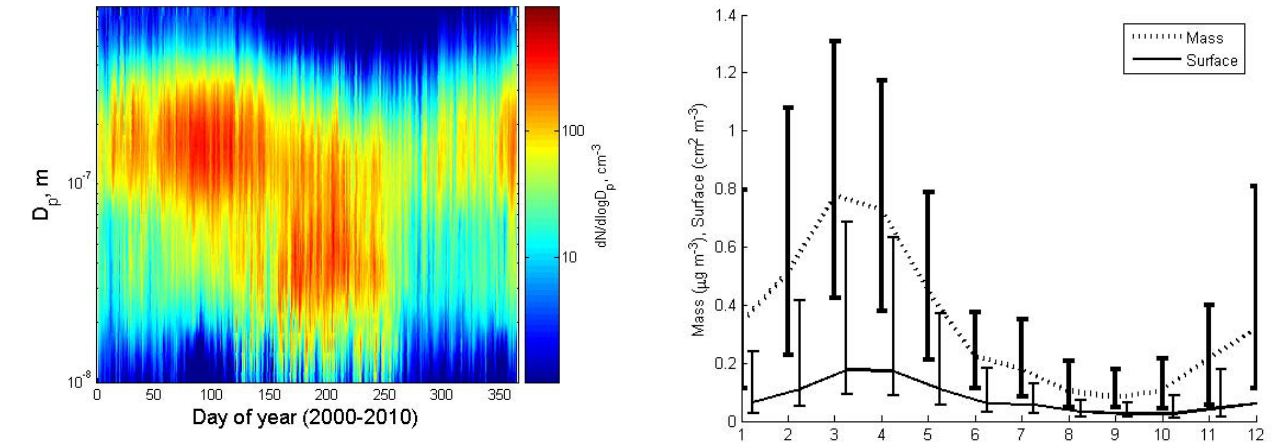
Fig. 6. Spectral plot of daily average aerosol number size distribu- tions, March 2000–December 2010. Units on x-axis as day of year.